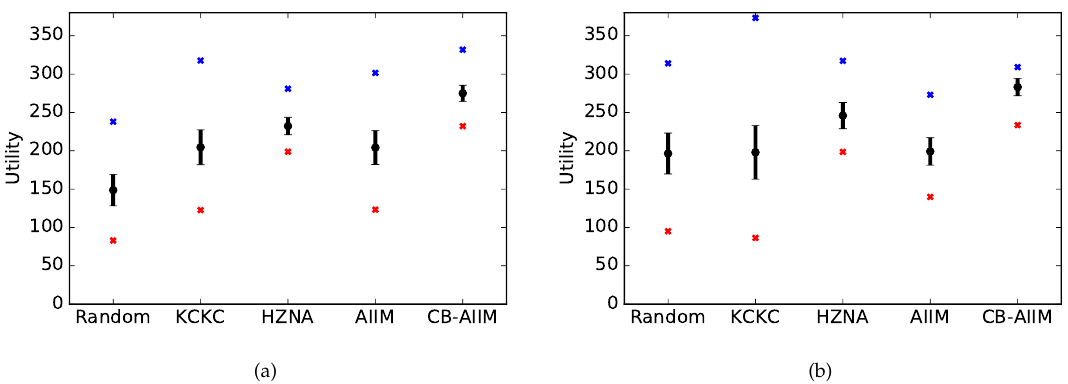
Figure 9. ( a , b ) Results for two different settings with total classroom occupancy (48 classrooms under